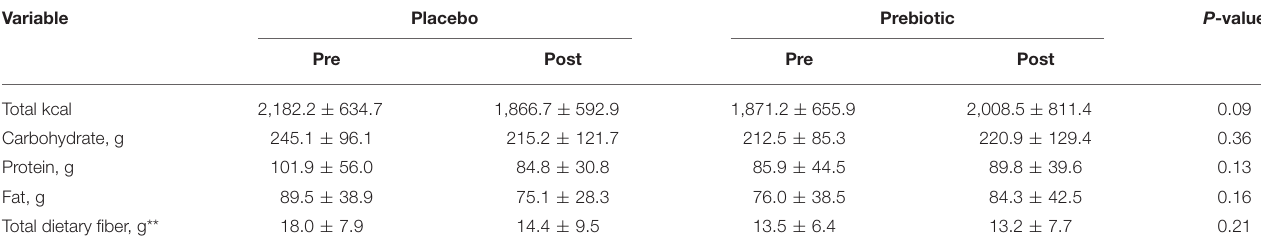
TABLE 2 | The composition of the background diet of participants pre- and post-treatment with placebo and prebiotic fiber*.